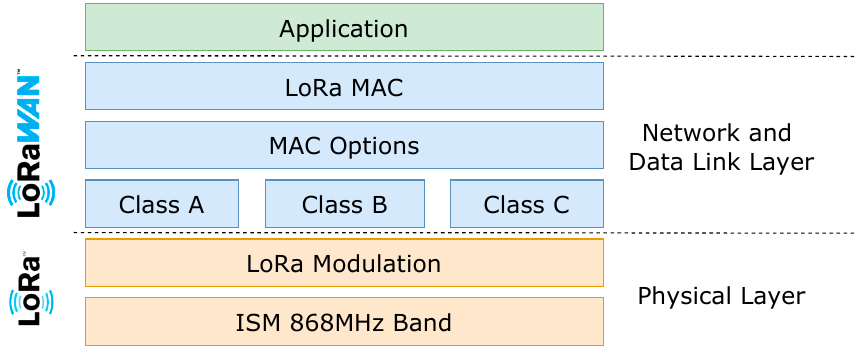
Figure 2. LoRaWAN layers.